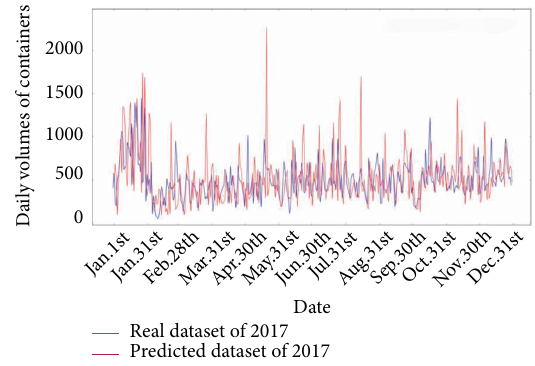
Figure 7: The comparison of the real data with the people-predicted data of